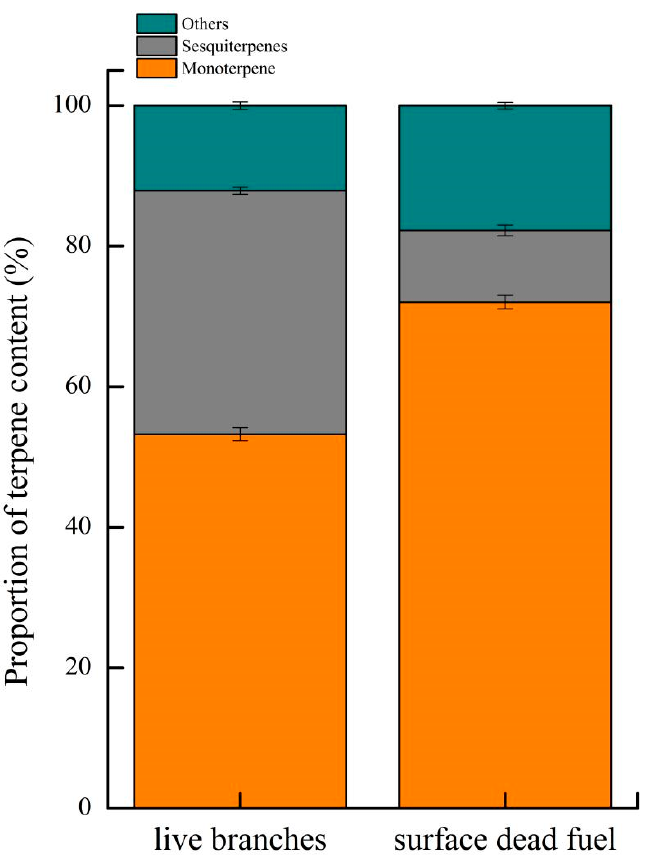
Figure 6. Proportions of monoterpenes, sesquiterpenes and other volatile compounds in live branches and surface dead fuel.